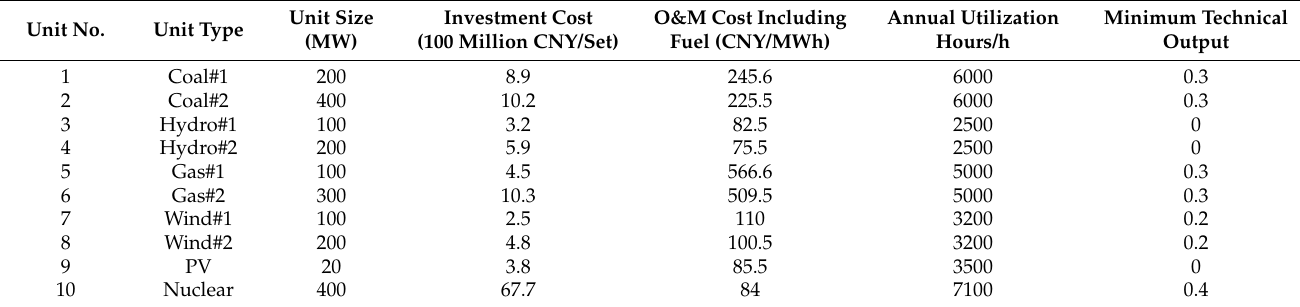
Table 2. Existing and pending unit types and their parameters.